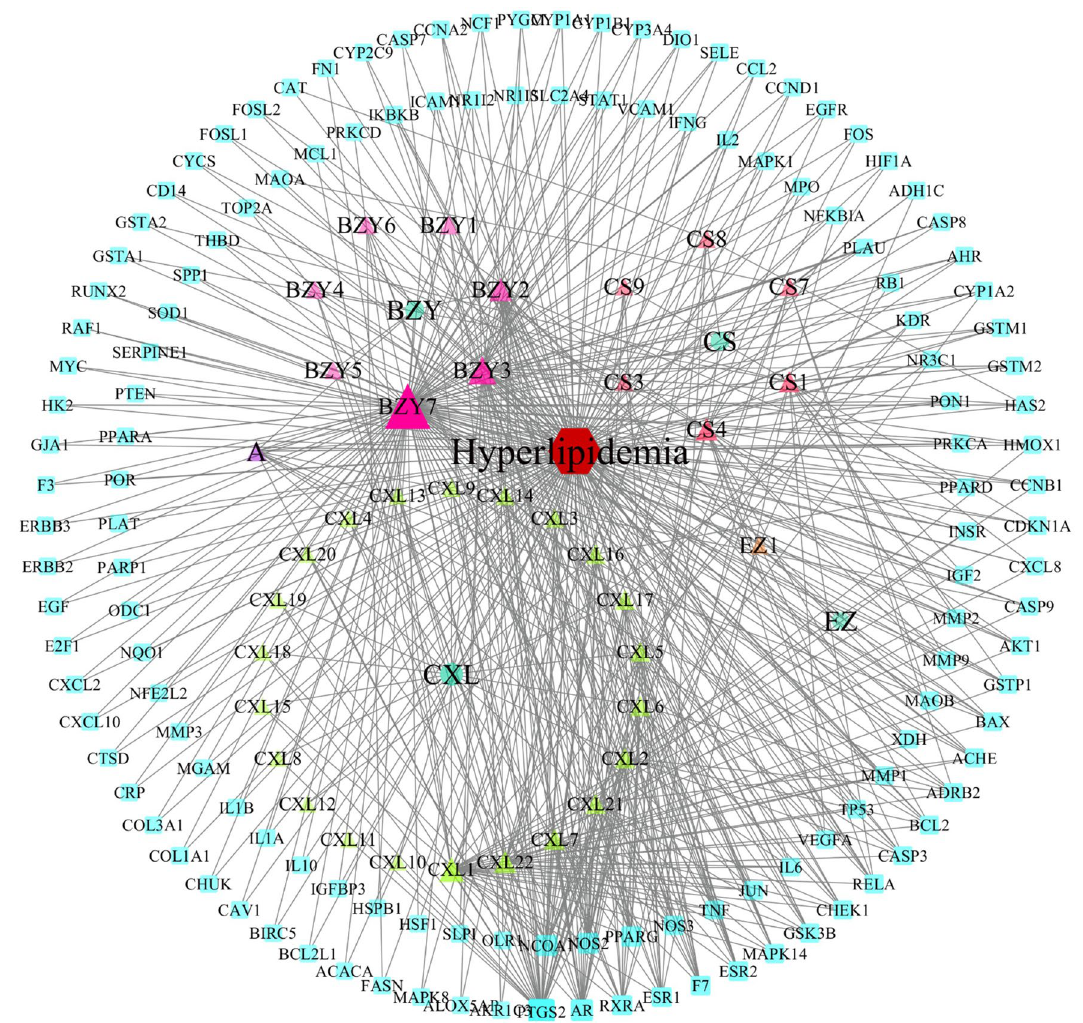
Figure 3. The Drug-Ingredients-Gene symbols-Disease (D-I-G-D) network of BSTZC.